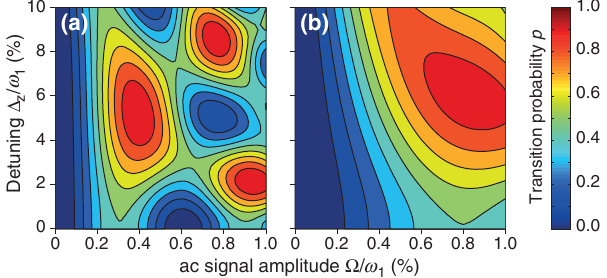
FIG. 3. Simulated transition probability for the (a) second and (b) fourth harmonics of the XY 8 sequence. The horizontal axis is the ac signal amplitude, and the vertical axis is the detuning. Further simulation parameters are N ¼ 1 ; 024 and ω 1 = 2 π ¼ 20 MHz.